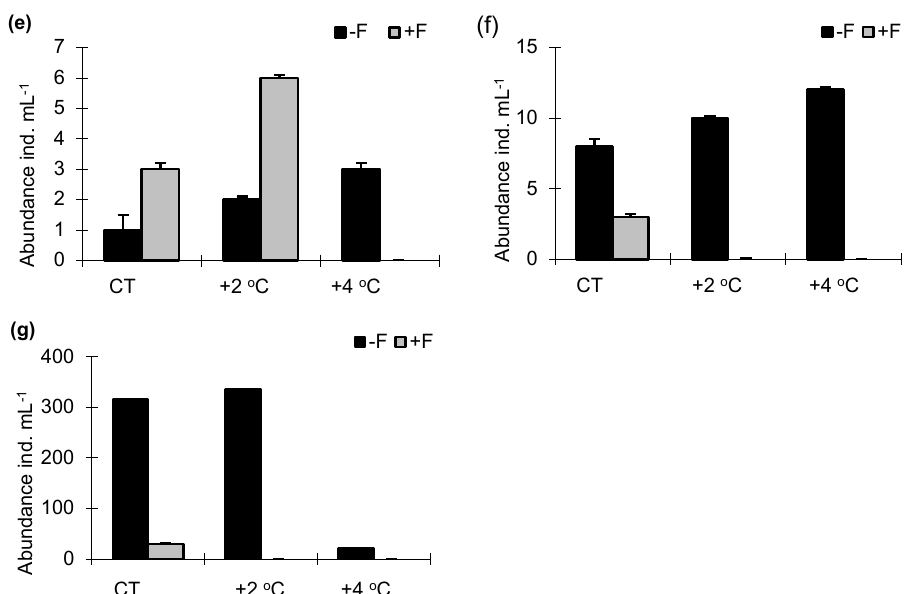
Figure 2. Numbers of ( a ) phycoflora; ( b ) bacteria; ( c ) heterotrophic flagellates; ( d ) testate amoebae; ( e ) ciliates; ( f ) cladocerans; ( g ) copepods in experimental mesocosms. − F treatments without fish; +F treatments with fish; CT—control treatments; +2 °C—treatment with temperature increased by +2 °C relative to the control; +4 °C—treatment with temperature increased by +4 °C relative to the control.